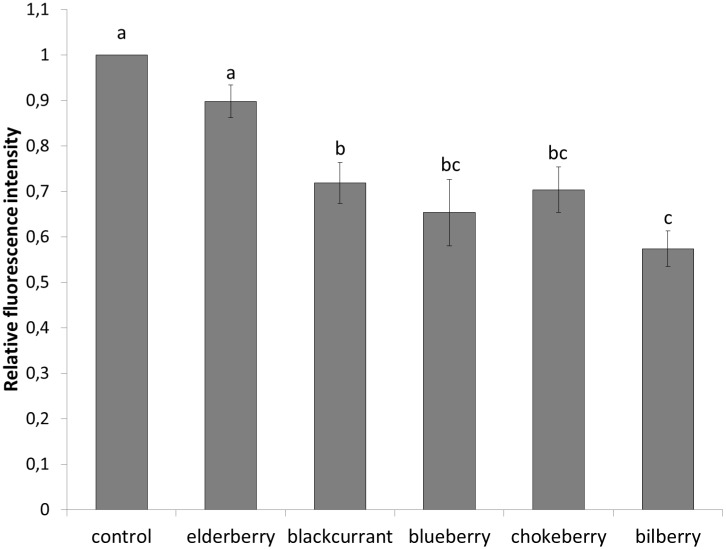
Intracellular oxidation in the yeast S. cerevisiae after 2-h exposure to different berry juices.Data are the mean ± SE, with values not sharing a common letter (a-c) being significantly different (Duncan's multiple-range test; p<0.05).